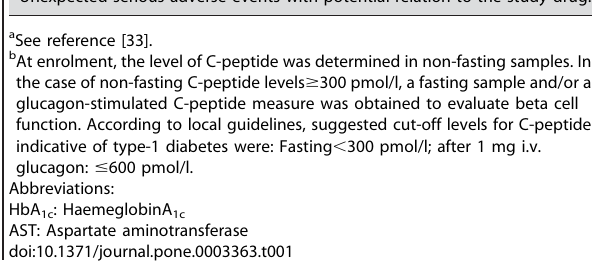
Gentofte, Denmark.